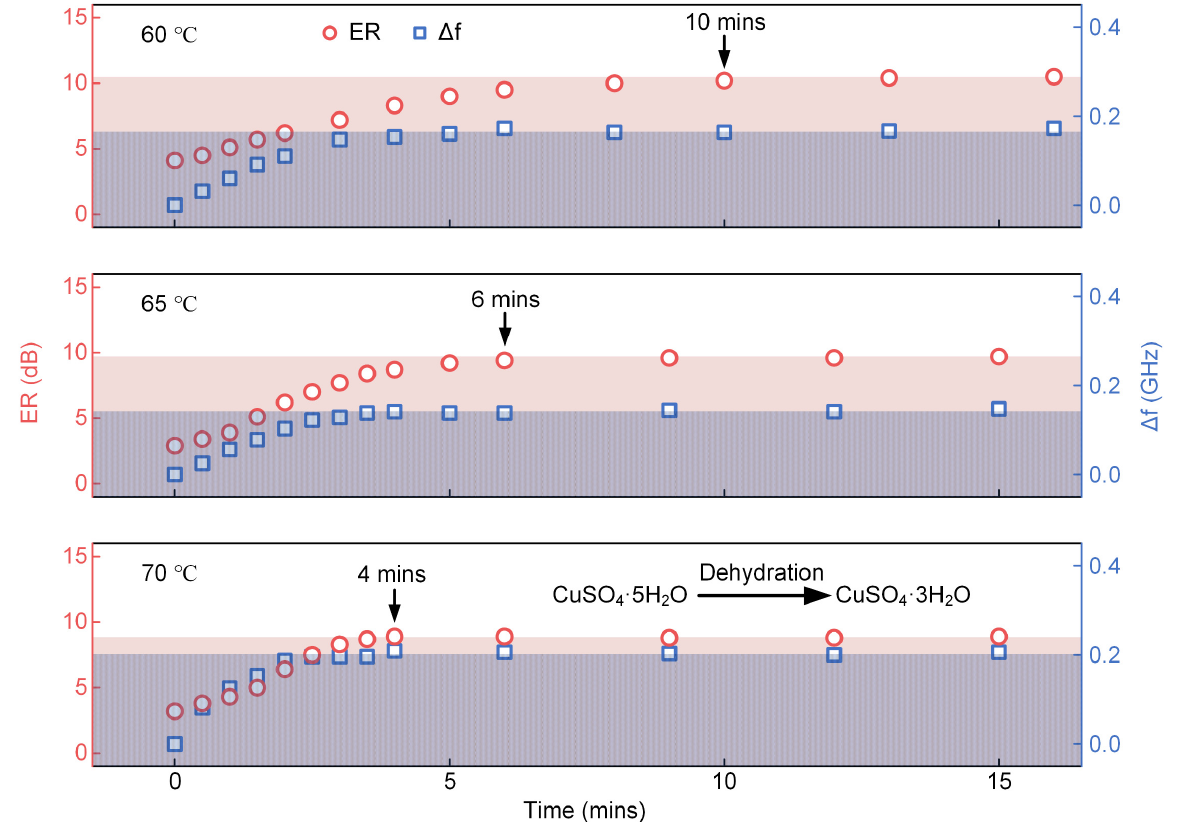
Figure 5. The dynamic dehydration from CuSO 4 · 5H 2 O to CuSO 4 · 3H 2 O at 60, 65, and 70 ◦ C, respec- tively. The ERs (red circles) and frequency shifts (blue squares) of the resonance dip along the time are demonstrated.